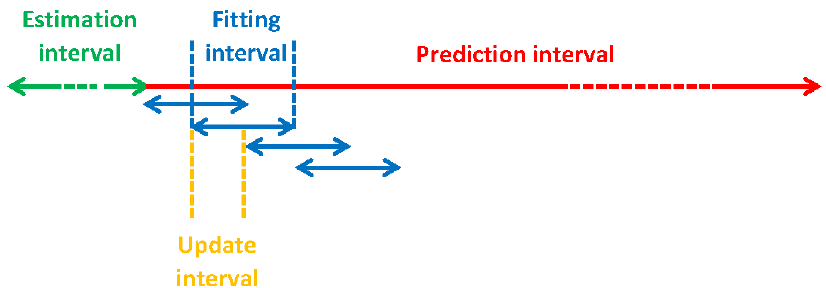
Figure 5. Relationships between the estimation, the prediction intervals of the orbits, the fitting and the update intervals ( ∆ t U ) of the ephemeris parameters.